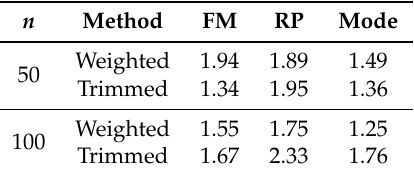
Table 1. Estimation of the false alarm rate (%) for the case of independence between curves using a nominal type I error of 1%.